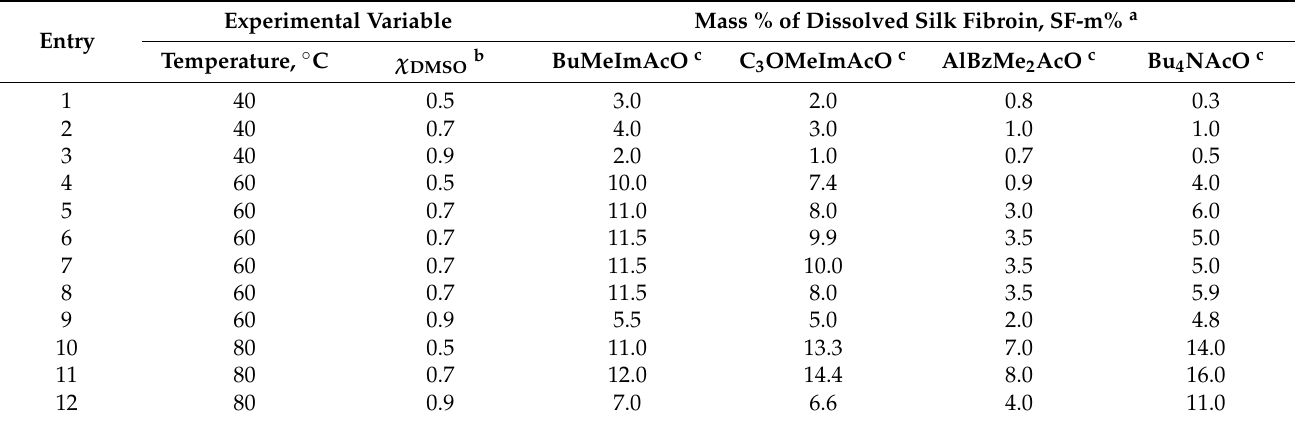
Table 2. Dependence of silk fibroin dissolution in ionic liquid/DMSO binary mixtures on the molecular structure of the IL, the temperature, and the composition of the binary mixture.